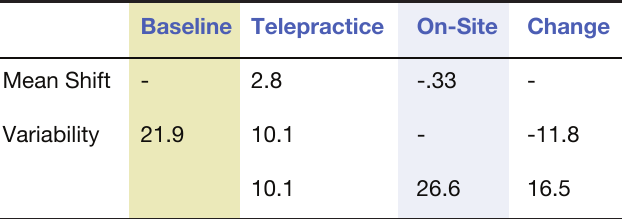
Table 3. Visual Analysis of Baseline, On-site and Telepractice Data